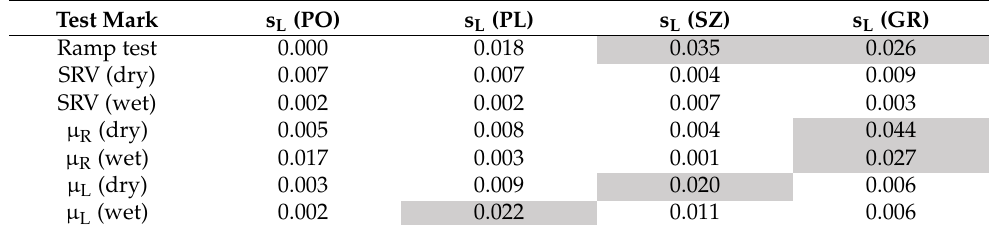
Table 3. Values of the intergroup deviation (s L ) . The values of s L for which s L2 had not met the condition described by Equation (2) are marked with gray